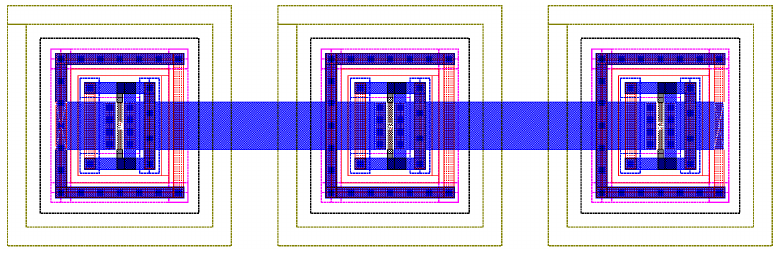
Figure 11. A close-up of the local ESD structure shown in Figure 10.